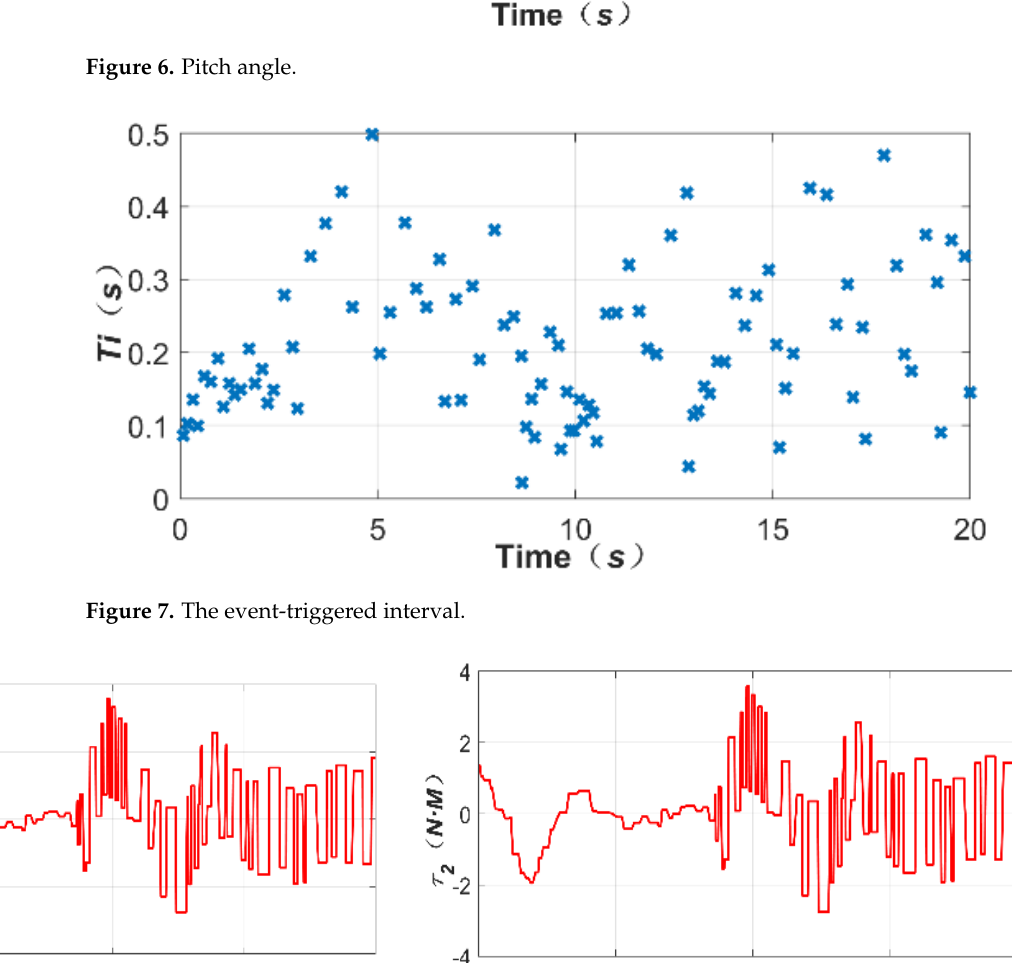
 and  ) 1 2  and  ) 1 2